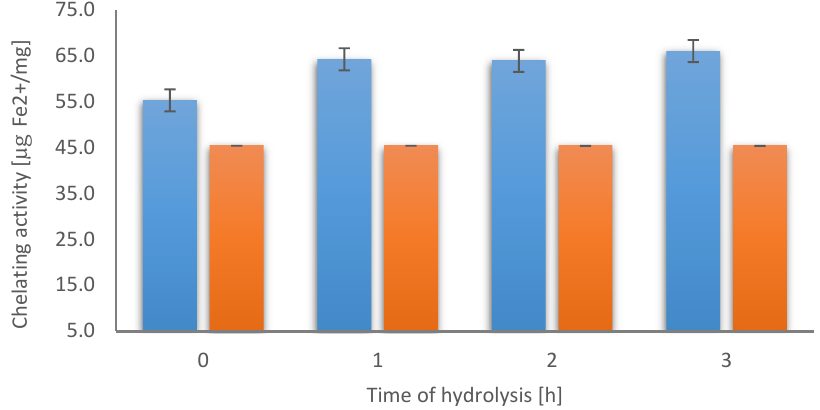
Figure 3. Chelating activity [ µ g Fe 2+ /mg protein] of casein hydrolysates degraded by serine protease from Yarrowia lipolytica yeast during 3 h of hydrolysis [blue], control sample: non-hydrolyzed isolelectric casein [orange].